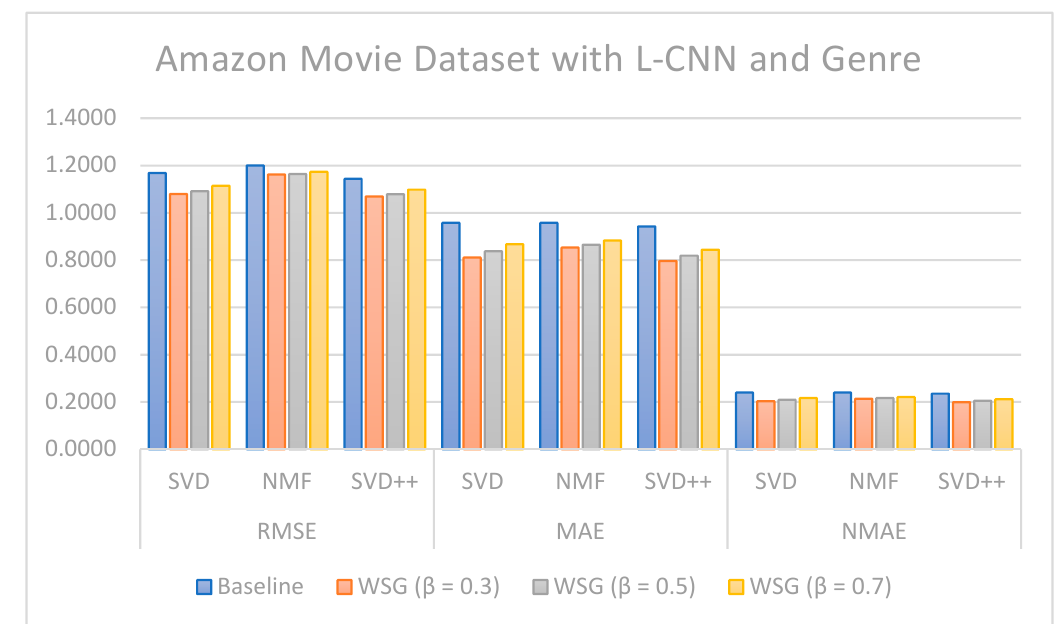
Figure 10. RMSE, MAE, and NMAE with and without L-CNN sentiment and genres-based model and different values of β on Amazon Movie dataset. Table 8. RMSE, MAE, and NMAE with and without C-LSTM sentiment and genres-based model and different values of β on Amazon Movie dataset.